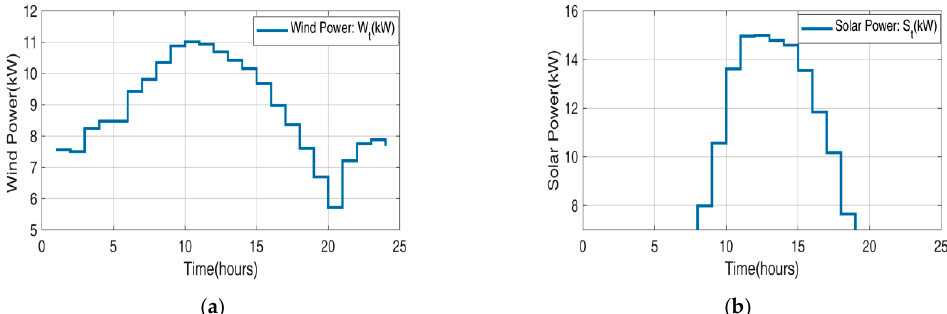
Figure 2. ( a ) Wind power availability curve; and ( b ) solar power availability curve. Table 2. Customer cost function related data.